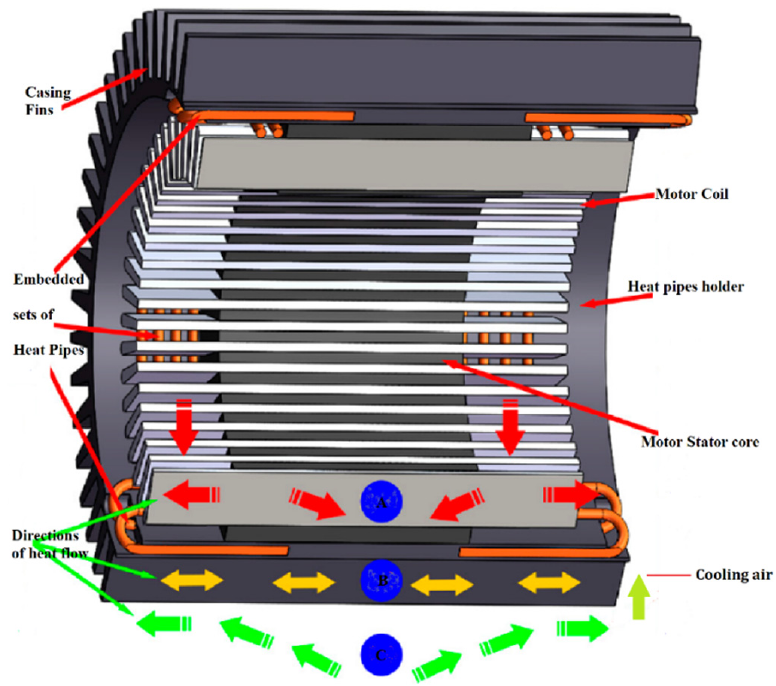
Figure 13. Schematic of L-shaped flat heat pipes mounted on an electric motor model [53]. Table 9. Effect of heat pipe implementation [52].